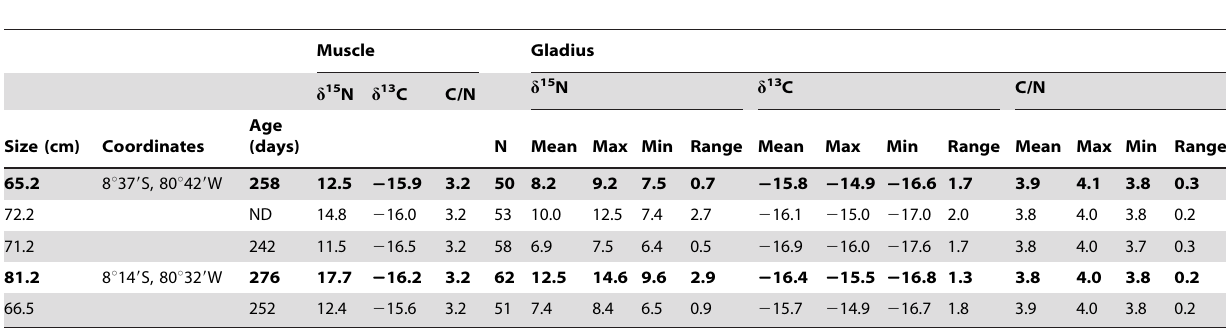
Table 1. Age, size, coordinates, isotope values and C/N mass ratios of the five large jumbo squids.